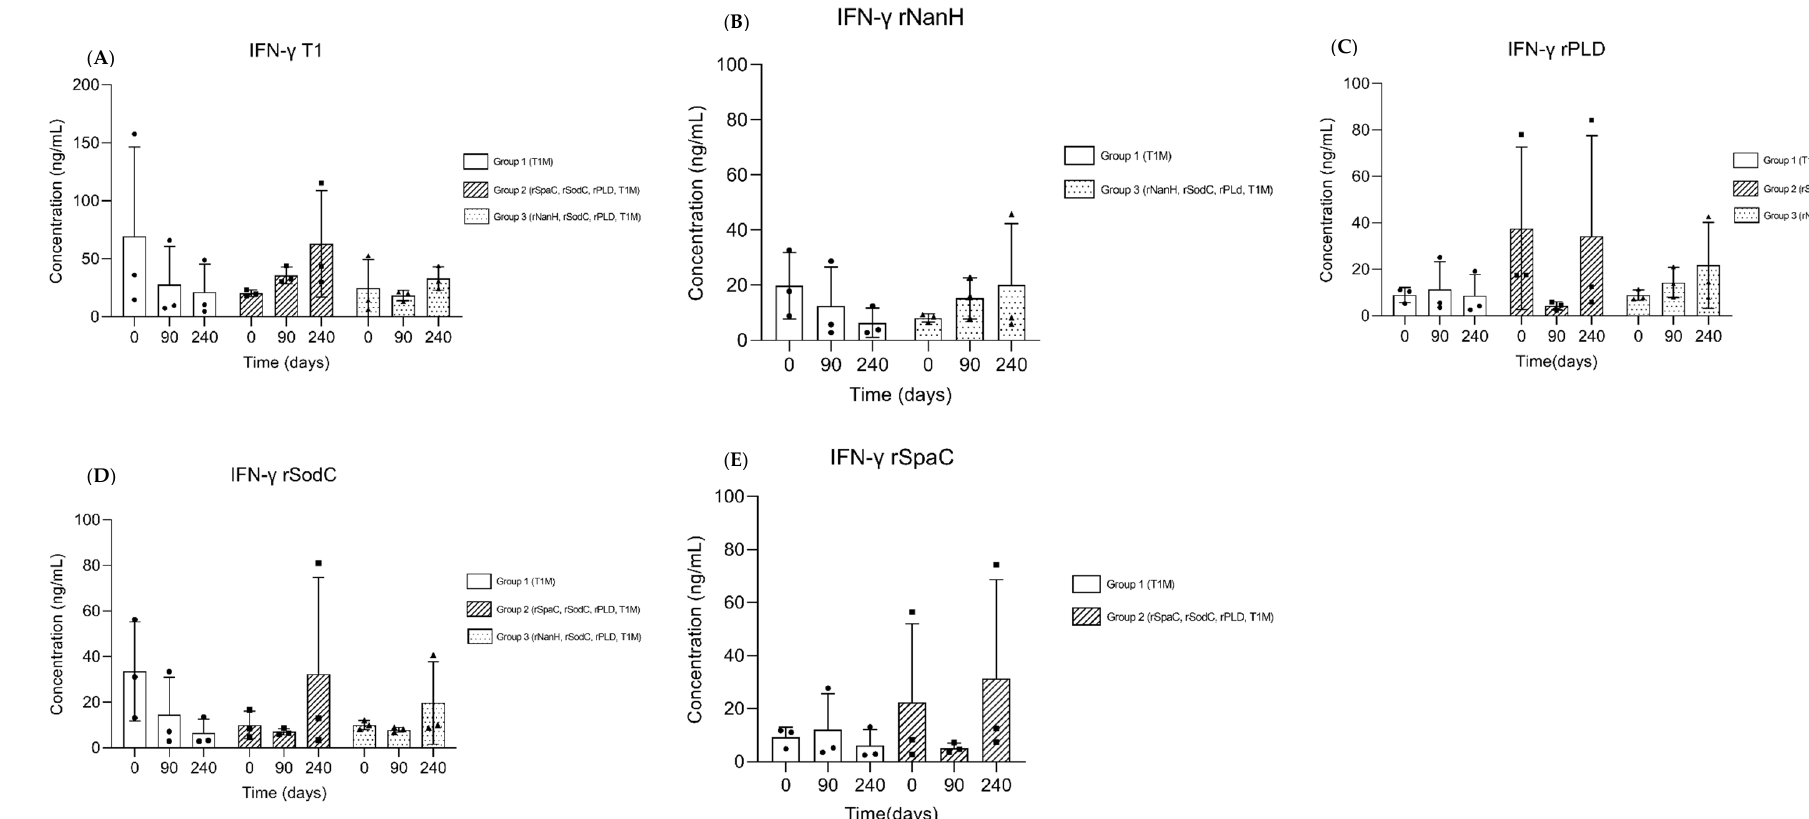
Figure 4. IFN-y response from sheep. Whole blood supernatant was stimulated with T1 ( A ) and recombinant proteins rNanh ( B ), rPLD ( C ), rSodC ( D ), and rSpaC ( E ), determined by anti-bovine IFN- γ mAb MT307, employed as described in the manufacturer’s protocol. Responses were determined on days 0, 90, and 240. Data represent the mean and standard deviation at OD450( n = 3) of sheep serum supernatant.